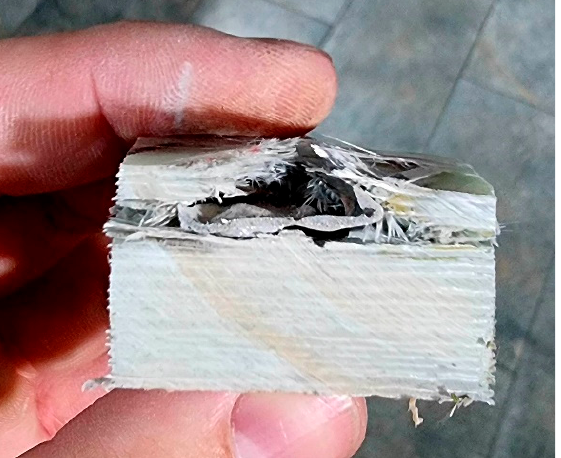
Figure 11. The cut sample for SEM investigation (after test with .357 Magnum).